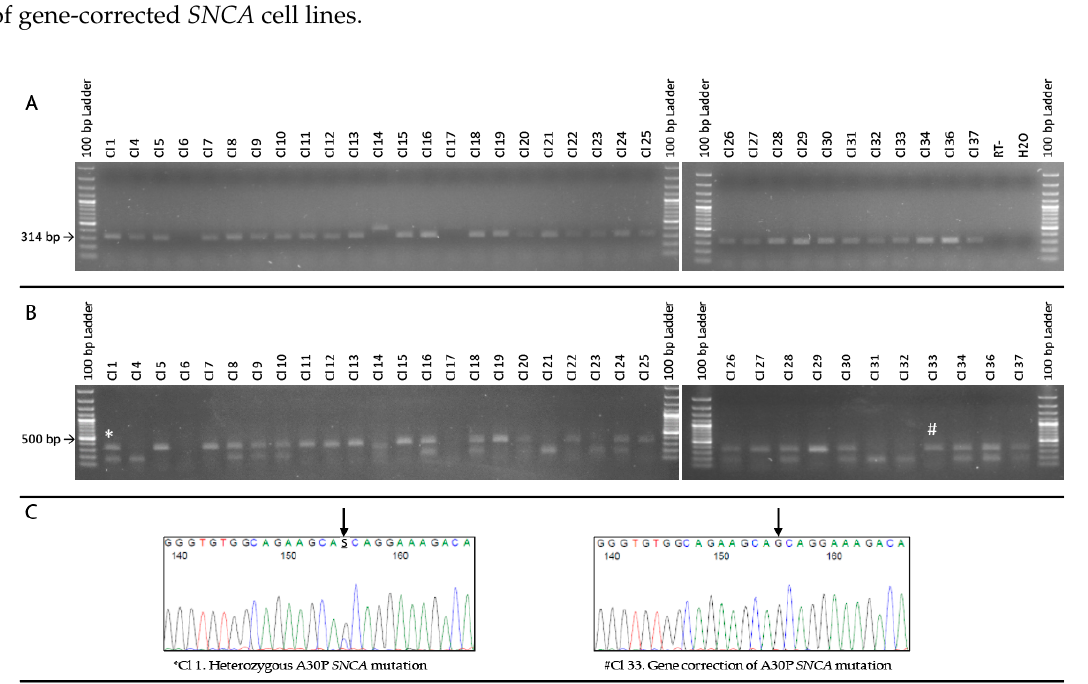
Figure 4. Restriction digest mediated clonal selection. ( A ) PCR amplification of single-cell clones. ( B ) Mva1 restriction digest post PCR amplification. *Double-band and #Unedited restriction digestion. ( C ) Sanger sequencing of the amplified sequence. Black arrow signifies the location of the c.88G>C SNCA mutation.